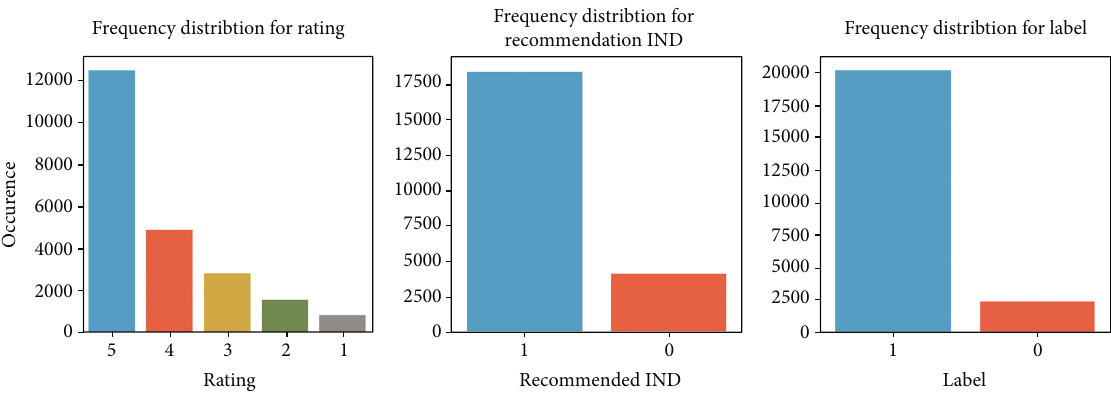
Figure 5: The frequency distribution of rating, recommended IND, and